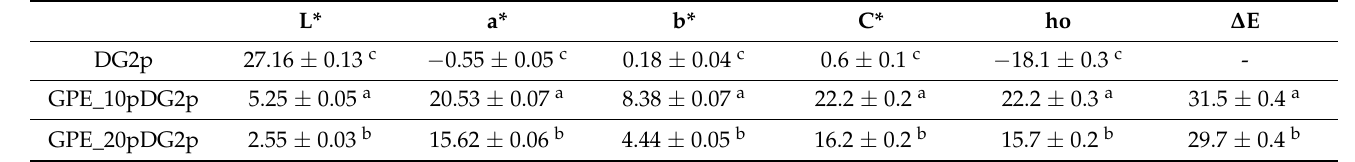
Table 4. Spectrophotometric data of the GPE_10pDG2p and GPE_10pDG2p obtained by